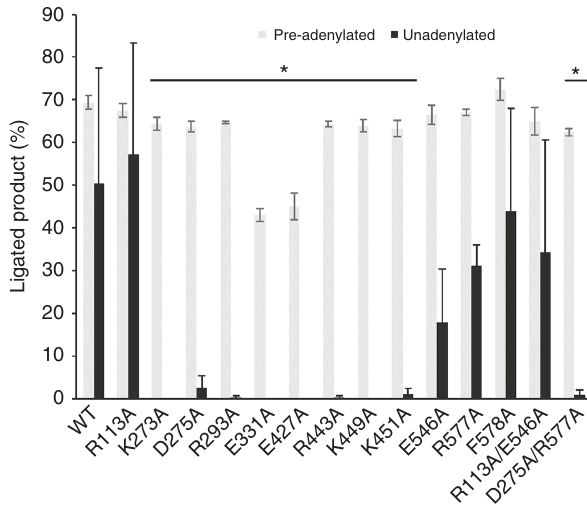
Fig. 6 Analysis of nick ligation by the wild-type and mutant LigIV catalytic domains. Levels of ligation activity for wild type and mutant LigIV catalytic domain constructs were examined using either unadenylated (black bars) or pre-adenylated (gray bars) substrates. 1 mM ATP was included in reactions with the unadenylated substrate, to aid in enzyme adenylation, and was not included in reactions with the pre-adenylated substrate. Extent of ligation product formation for each LigIV variant is indicated, as mean ± standard deviation. (*, p < 0.05, WT vs. LigIV